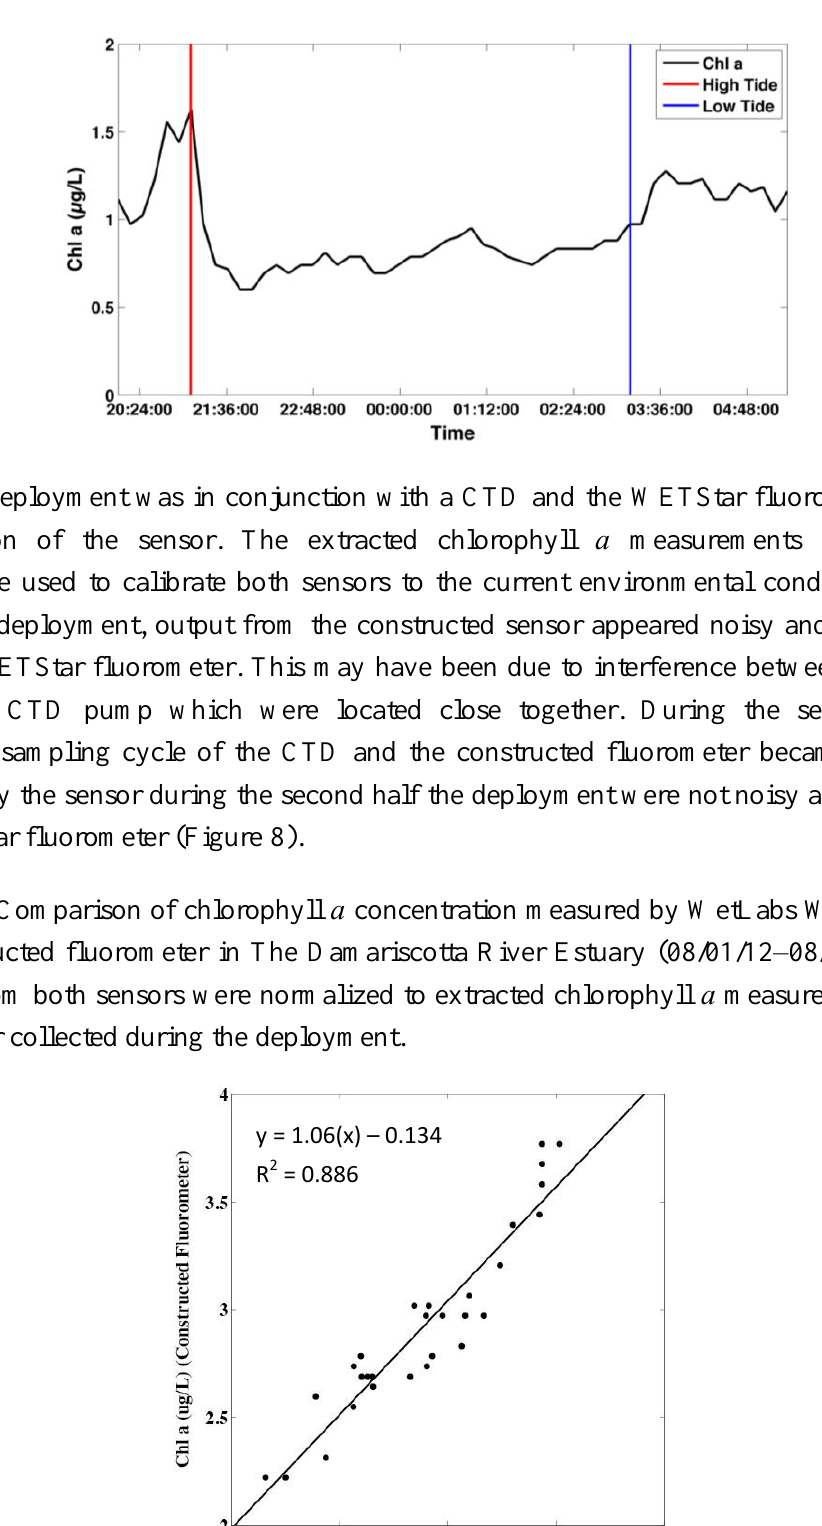
Figure 7 . Time series of chlorophyll a concentration measured in the Damariscotta River Estuary during first deployment (04/03/12–04/04/12). Vertical lines show time of high and low tide.